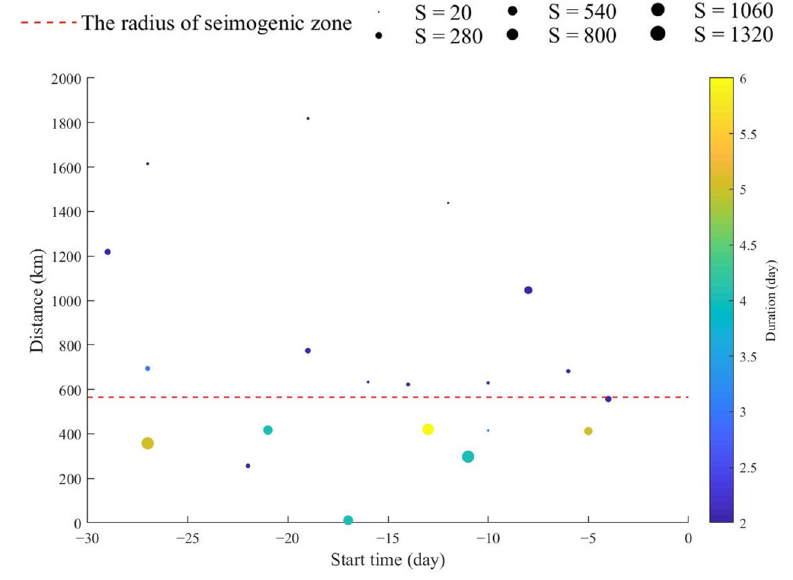
Figure 9. The anomaly information of Yangbi earthquake.